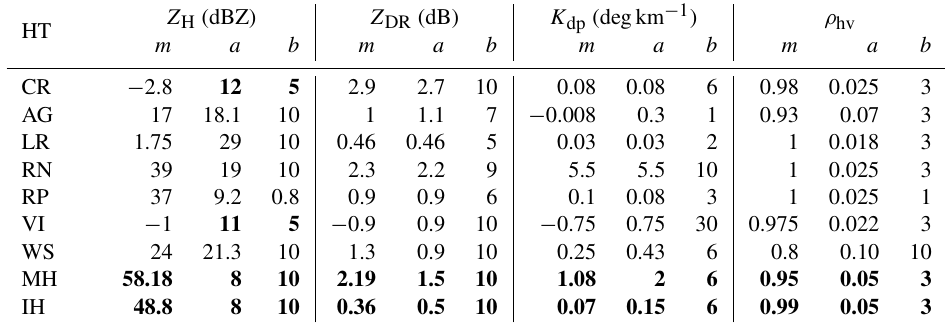
Table A1. C-band membership function parameterisation. The modified parameters are emphasized using bold font. HT